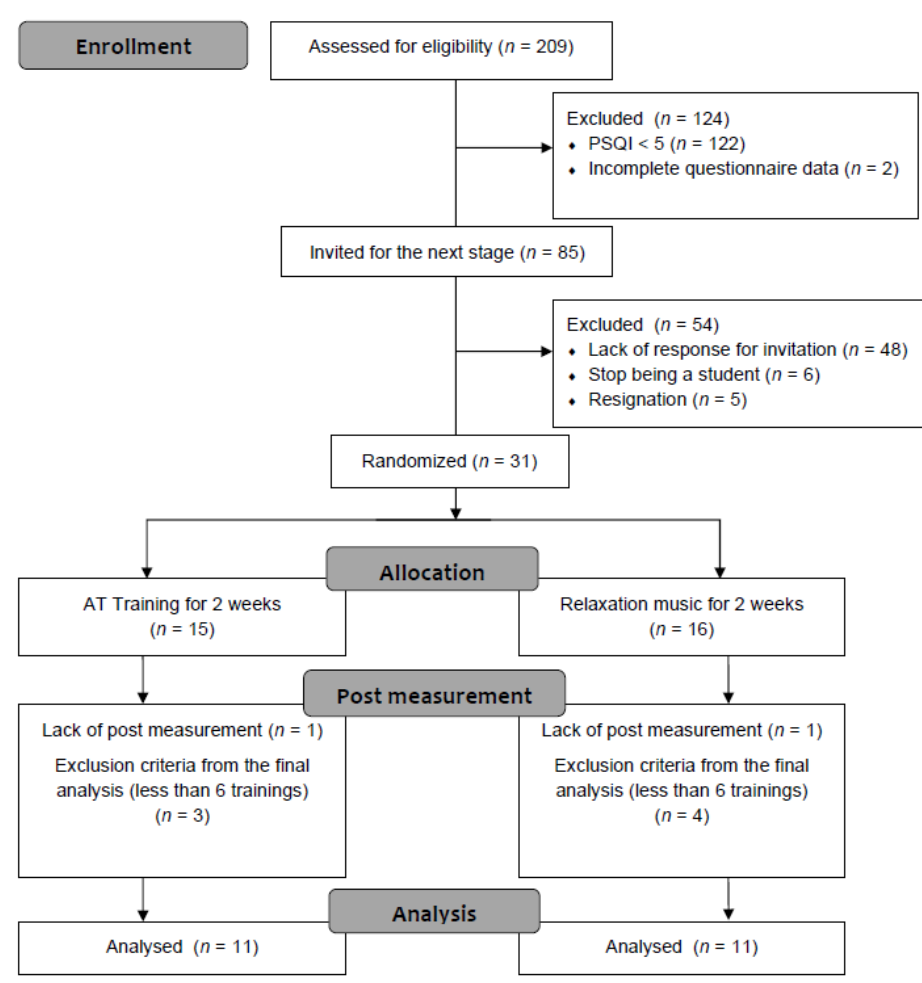
Figure 1. Participants flowchart.